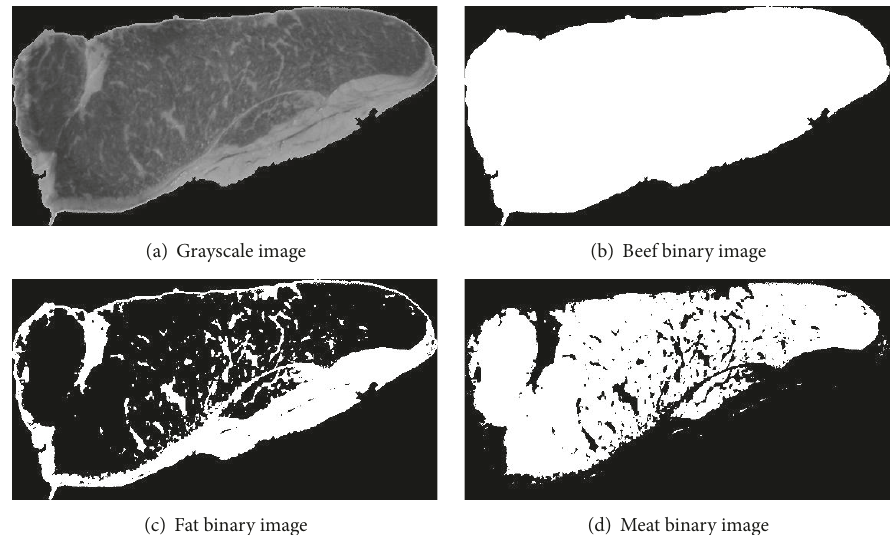
Figure 6: The second stage of beef